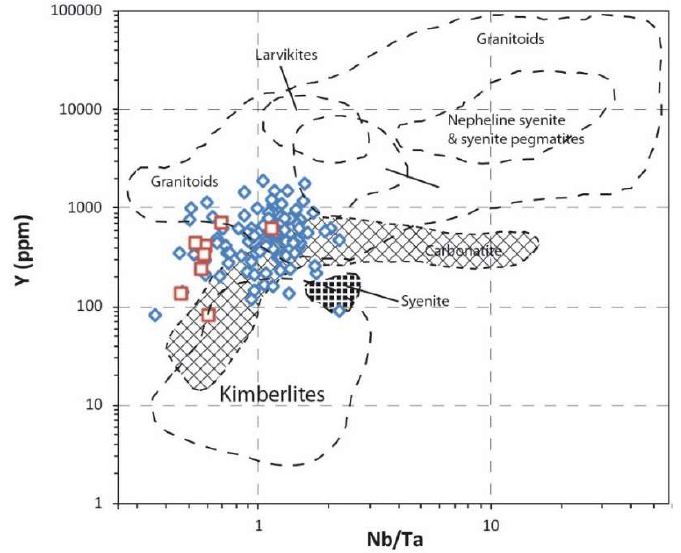
Figure 8. Y versus Nb/Ta plot of western Meiganga magmatic zircons (adapted from [19,54], blue and white diamond-shape plots are for magmatic zircons; red and white square plots are for metamorphic zircon).